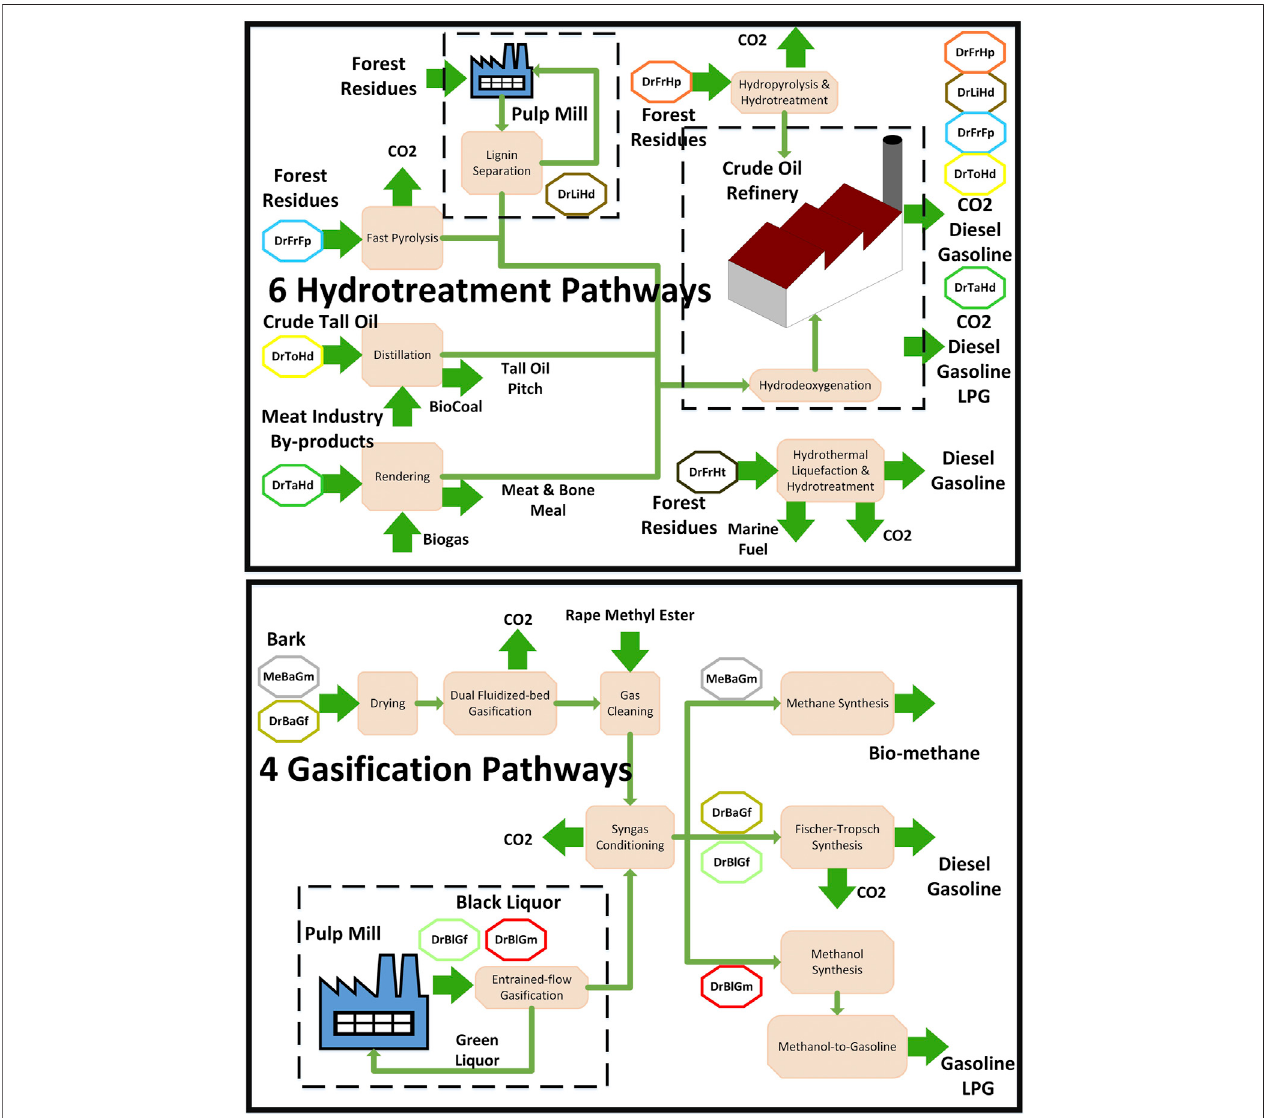
FIGURE3| Simpli fi edschematicoverviewsofthehydrotreatmentandgasi fi cationpathways.Abbreviationsareusedtoseparateprocessstepsandinputs/outputs that are speci fi c to apathway from those that are common totwoor more pathways. Only biogeniccarbon fl ows are shown. Dashed lines indicate physical boundaries. For detailed process con fi gurations, see the Supplementary